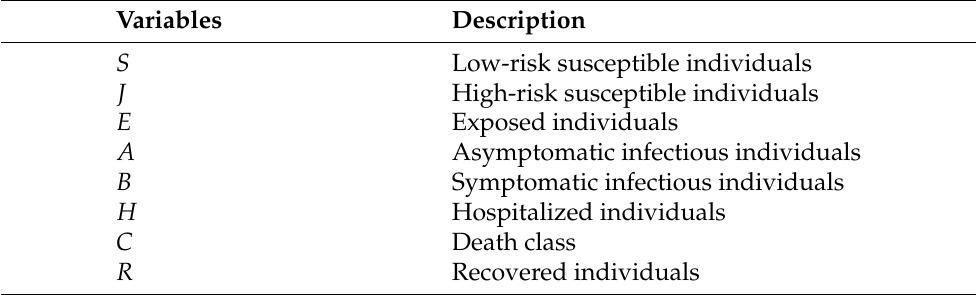
Table 1. Description of state variables of model